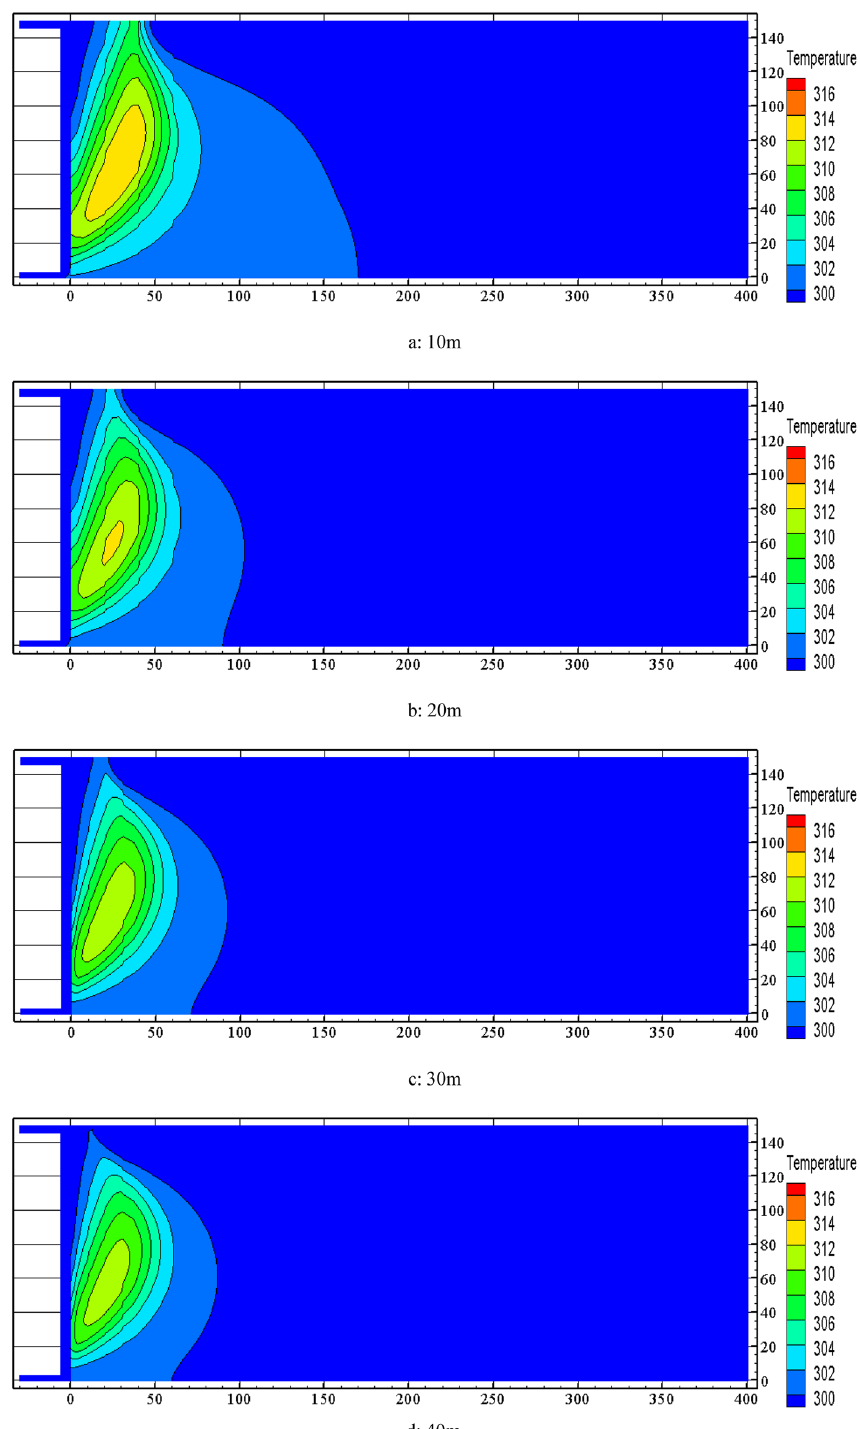
Figure 9. Effect of nitrogen injection location on temperature field in